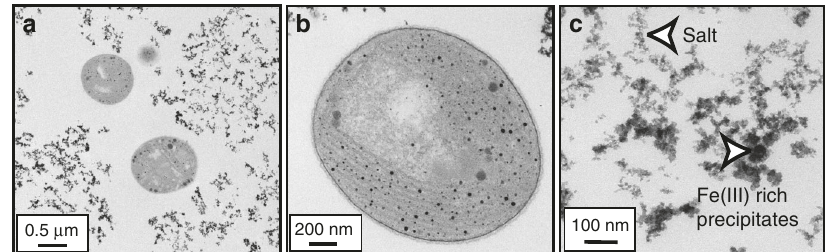
Fig. 3 TEM imaging of Synechococcus cells and precipitates. a Transmission electron microscopy (TEM) image of nanoparticles surrounding (but not associated with) the cells in the presence of 0.35 mM Fe(III) and 2.0 mM Si. b TEM image showing the lack of biomineralization on Synechococcus . c Dark Fe(III)-rich precipitates and lighter salt nanoparticulates surrounding cells grown under conditions as shown in